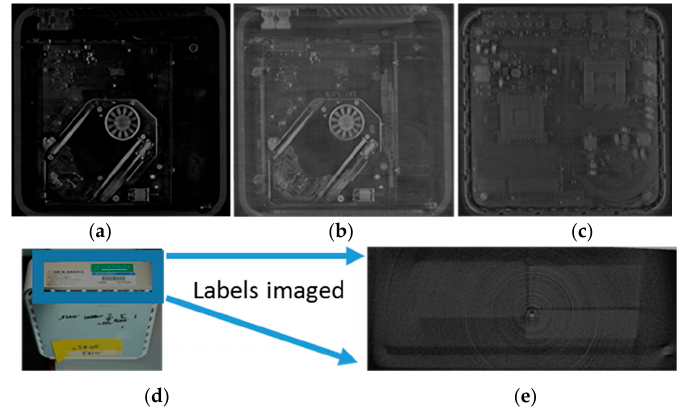
Figure 14. X-ray (6 MeV) CT ( a ) and thermal neutron CT slices ( b , c ) taken at the 1FP-05 60 m